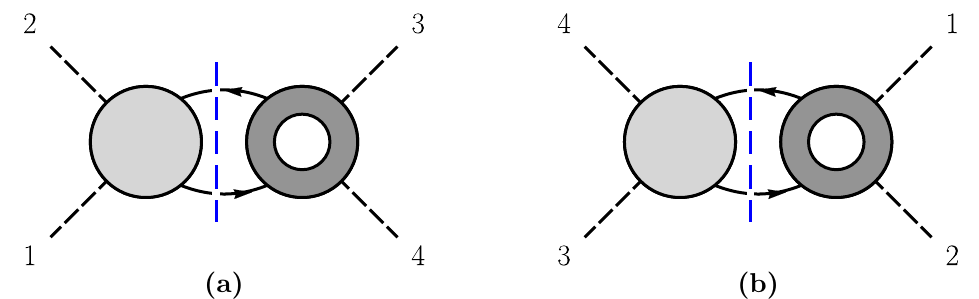
Figure 6 . The (a) (12)-channel and (b) (34)-channel unitary cuts which determine the renormal- ization of O and O by O or O . The (23)- and (14)-channel cuts are given by ( D 2 ’ 4 ) 1 ( D 2 ’ 4 ) 2 ( 4 ) 1 ( 4 ) 2 exchanging legs 2 and 4. In each, the darker blobs indicate a higher-dimension operator insertion, and the vertical (blue) dashed line indicates the integral over phase space of the particles crossing the